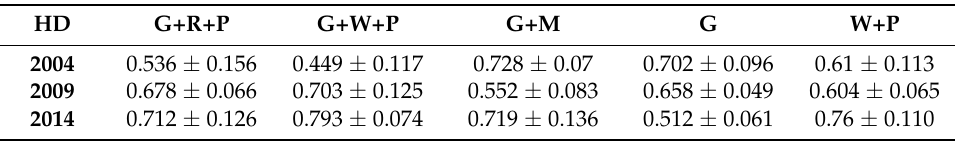
Table 7. Harmony degree (HD) in three mixed Ginkgo systems, pure Ginkgo (G), and a cropping system (W+P), over three time